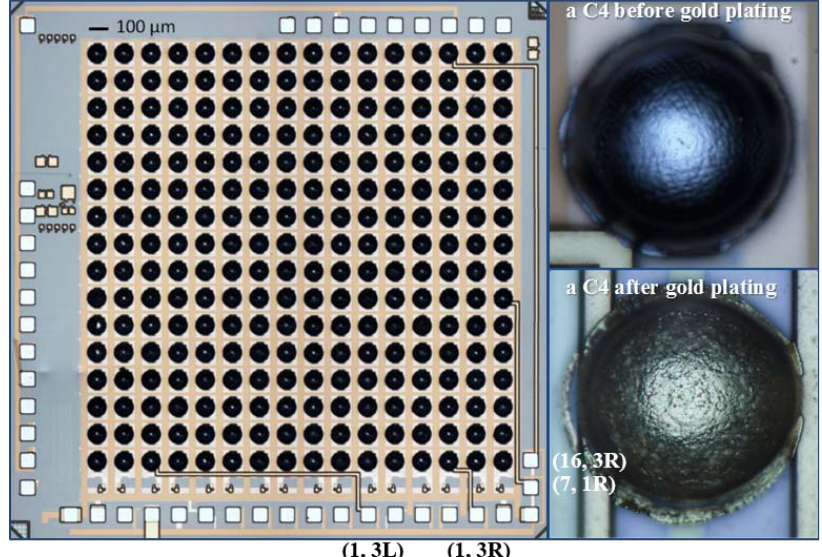
Figure 1. Micrograph of the fabricated neural recording integrated circuit (IC). The input channels with direct connections to the package are all labeled near the chip’s corresponding pads. The C4 image is compiled from a number of different focus points on the microscope; i.e. , to see the whole C4, this and the previous C4 images were assembled from multiple Z